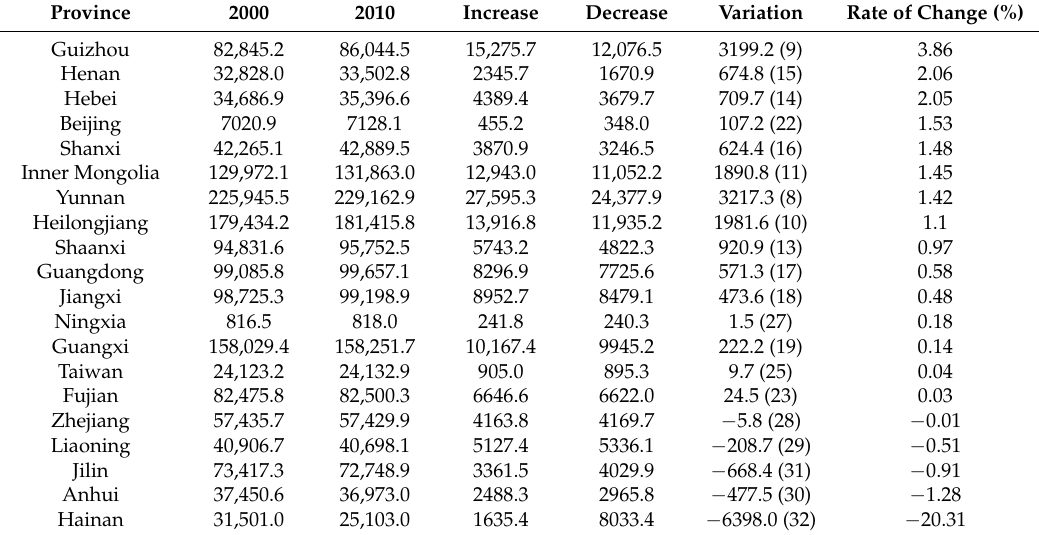
Figures given in brackets are the rankings of forest area